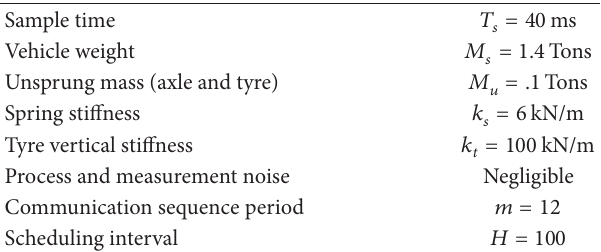
Figure 5: Estimation errors for the round robin with RTZ and ZOH. Table 1: Simulation